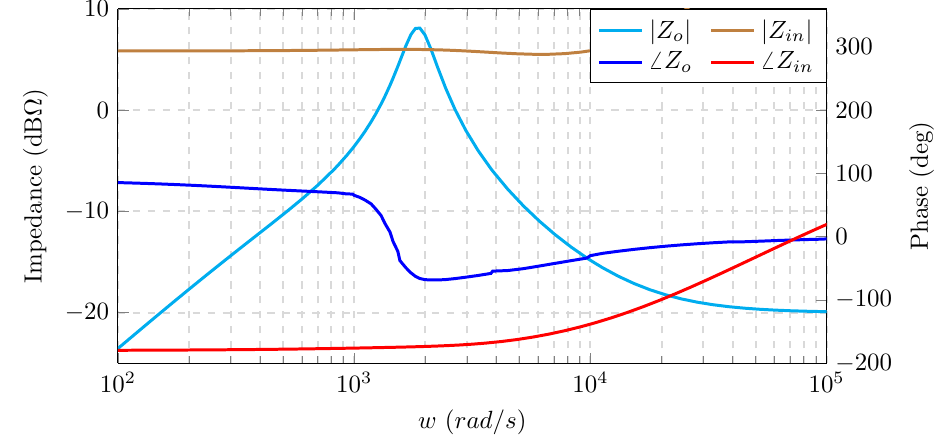
Z o ( s ) and the load input impedance | |